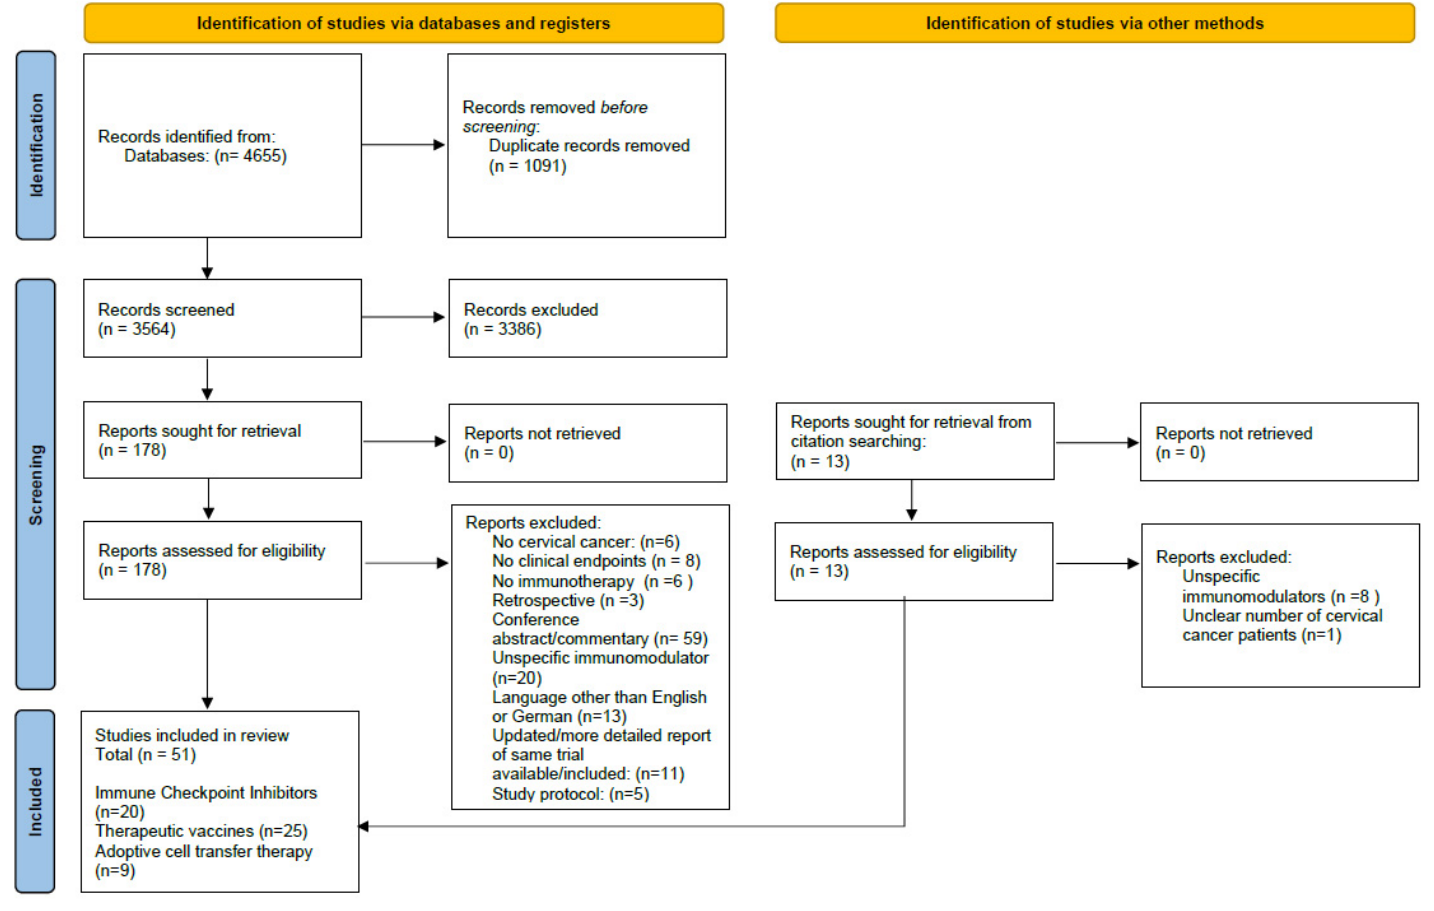
Figure 1. PRISMA flowchart of the screening and inclusion process.